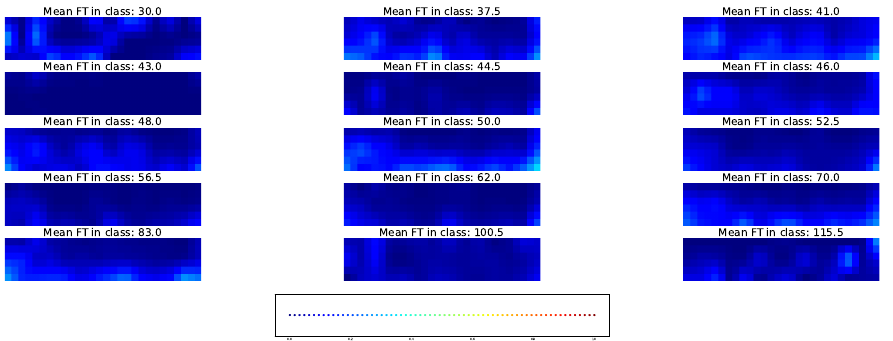
Figure 13. Average Score-CAM maps for time classes and cross-SNP set. Figure S4 gives the same data with higher